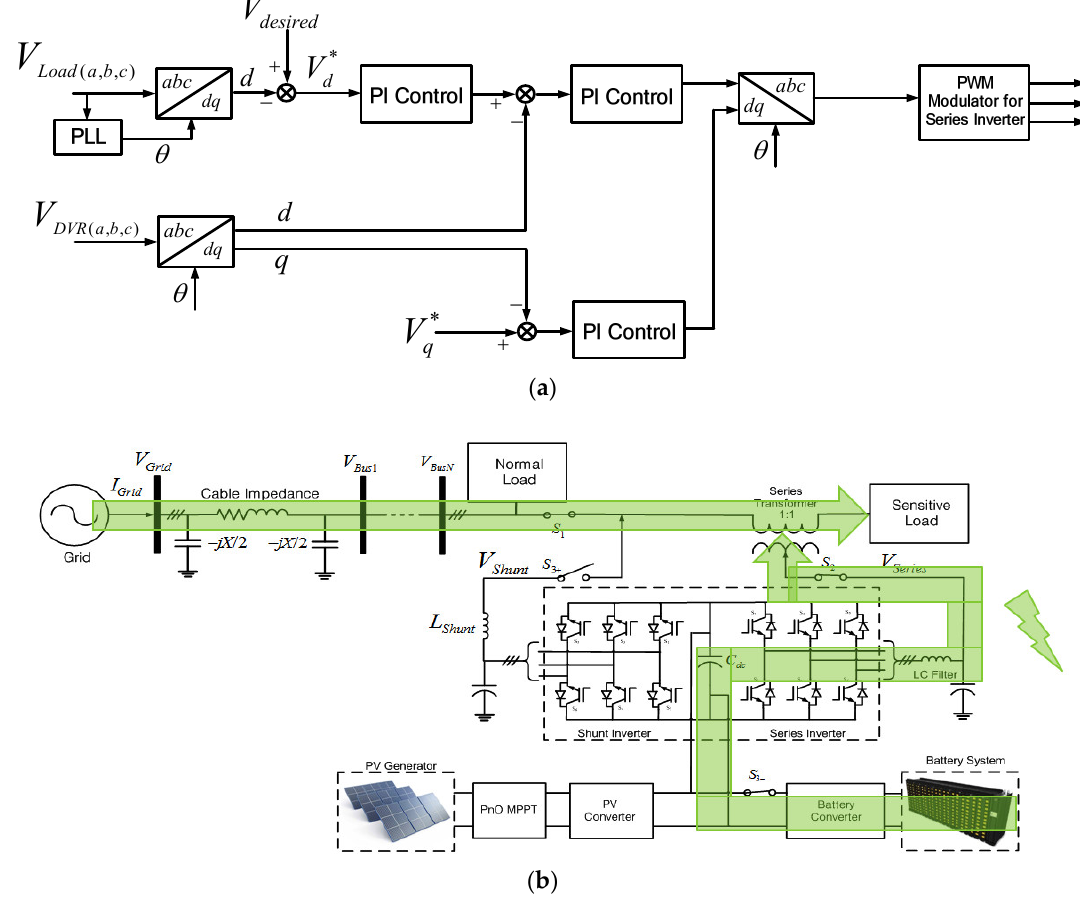
Figure 9. Voltage compensation mode from BESS: ( a ) Control scheme; ( b ) power flow condition.